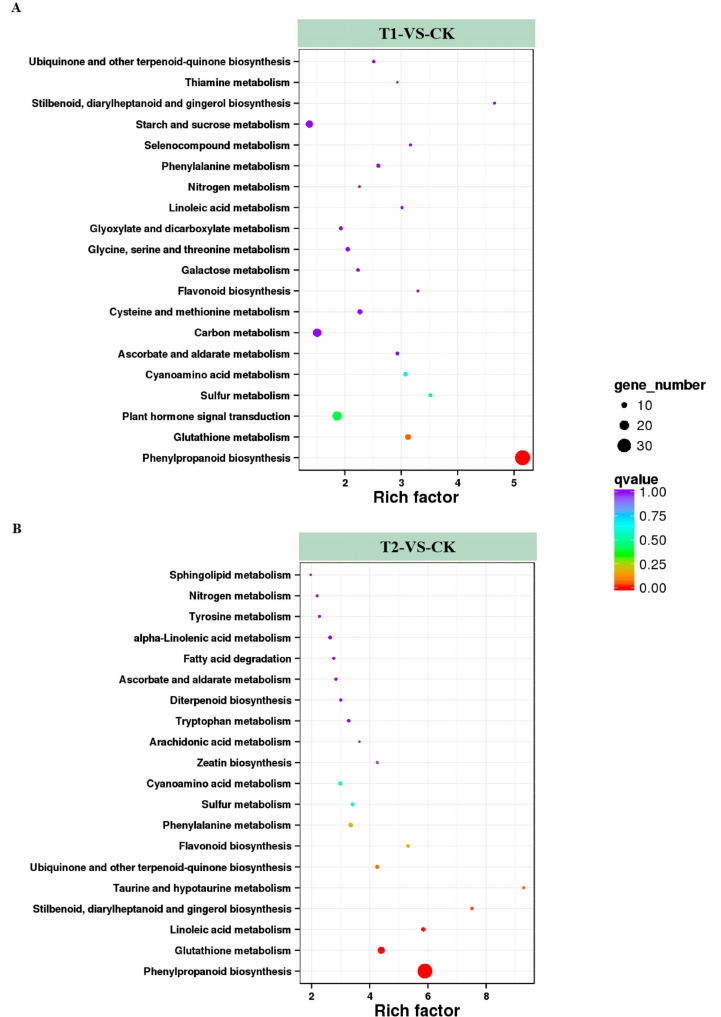
Figure 5. Enrichment analysis of KEGG (Kyoto Encyclopedia of Genes and Genomes) pathways. The top 20 pathways with the highest enrichment levels are shown according to the amount and enrichment level of DEGs annotated in T1 ( A ) and T2 ( B ) by pairwise comparisons to CK. The x -axis represents the rich factor, which was measured by the Q value and was proportional to the enrichment level. A deeper color represents the higher significance of the DEGs. The y -axis represents the KEGG pathways. A bigger size of spot represents more DEGs